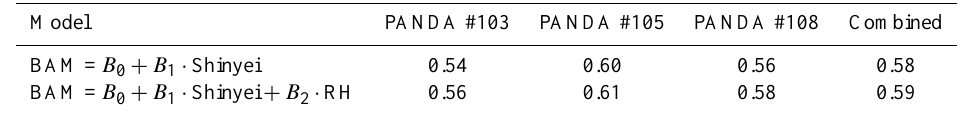
Table 1c. Adjusted R 2 for linear regressions of BAM on Shinyei, with and without